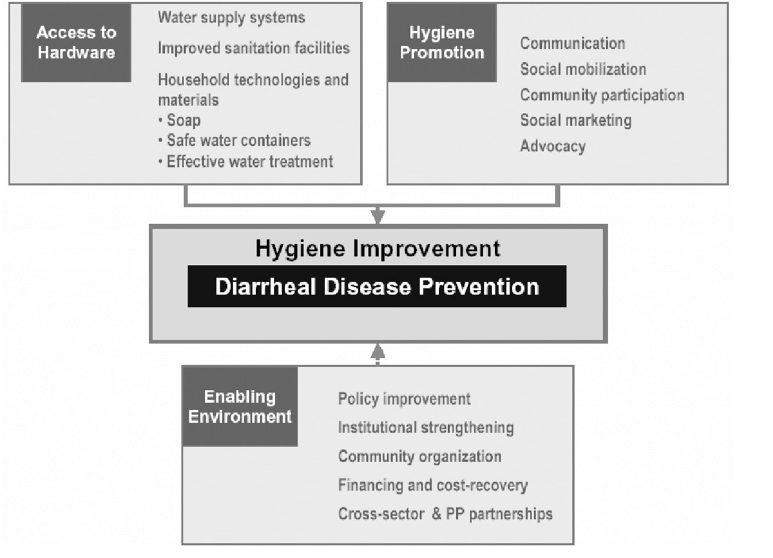
Fig 2. The hygiene improvement framework